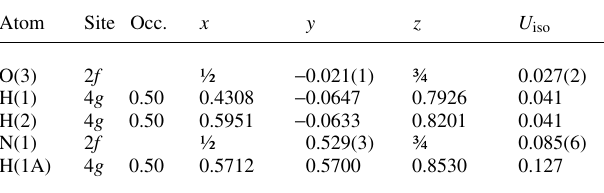
Table 2. Atomic coordinates and displacement parameters (in Å 2 )